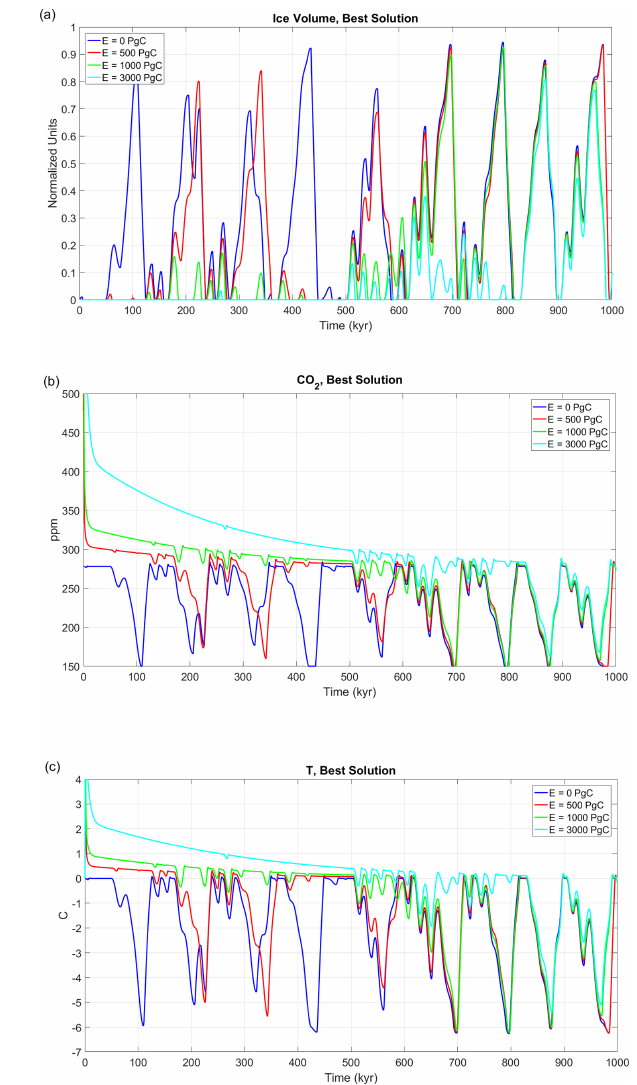
Figure 9. Best Solution under different emission scenarios: (a) ice volume (normalised to unity), (b) CO 2 (ppm), (c) global mean sur- face temperature anomalies (C).